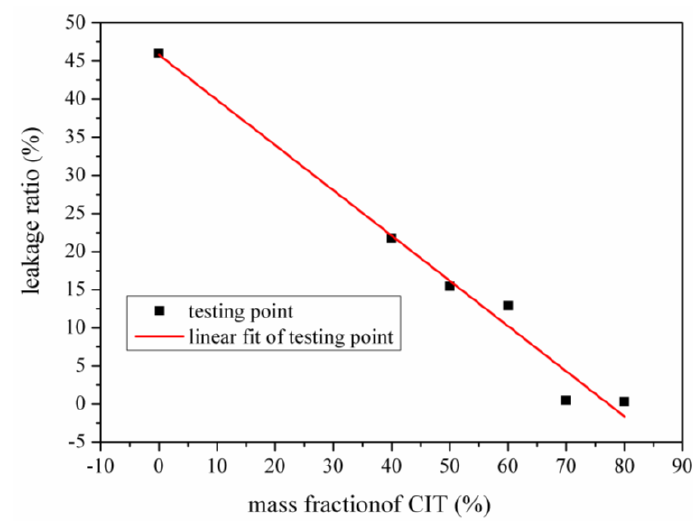
Figure 5. Leakage area of CA / CIT composites with di ff erent mass fractions of CIT.